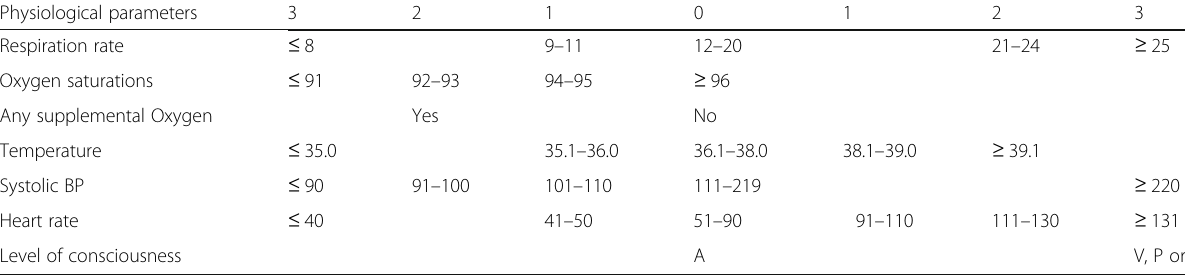
Table 1 National Early Warning Score (NEWS) [10] Physiological